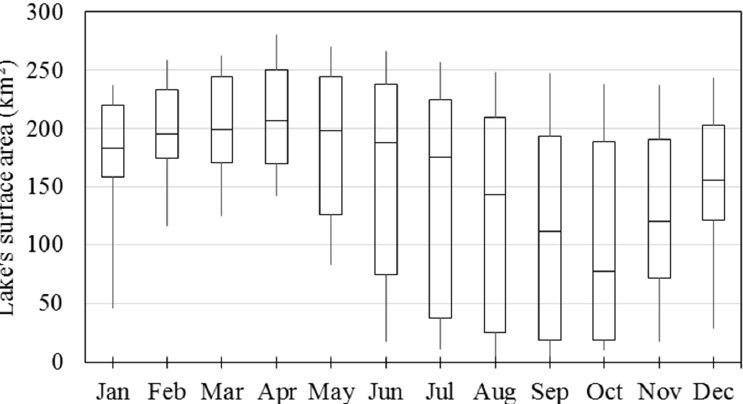
Figure 4. Average monthly variation of Maharlou Lake’s surface area from 1992 to 2017.